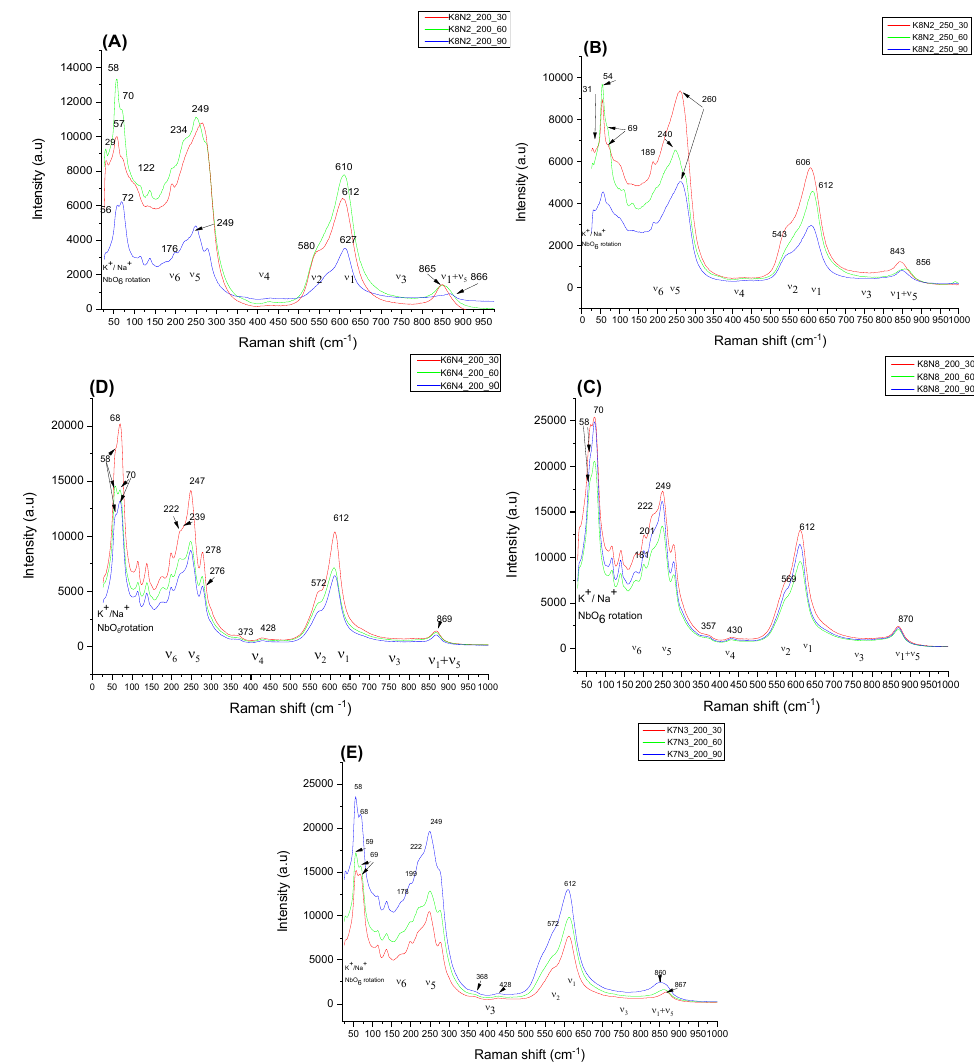
Figure 8. Comparative Raman spectra for the series of samples K8N2_200_30–K8N2_200_90 ( A ), K8N2_250_30–K8N2_250_90 ( B ), K8N8_200_30–K8N8_200_90 ( C ), K6N4N_200_30–K6N4N_200_90 ( D ) and K7N3_200_30-K7N3_200_90 ( E ). The microwave radiation has an accelerating effect of nucleation versus crystal growth, so powders obtained after a short time (30 min) generally have small sizes, such as the sample K7N3_200_30 which contains 70% particles under 100 nm and K/Na content ~1. The gradual increase in grain sizes with dwelling time (60 and 90 min) was not confirmed for all samples. The largest particle sizes are generally found in specimens with longer treatment durations (K6N4_200_60 by 1.6 µ m, K7N3_200_90 by 1.209 µ m) and at higher temperatures (K8N2_250_60 of 2.95 µ m), which accelerates crystal growth compared to the nucleation